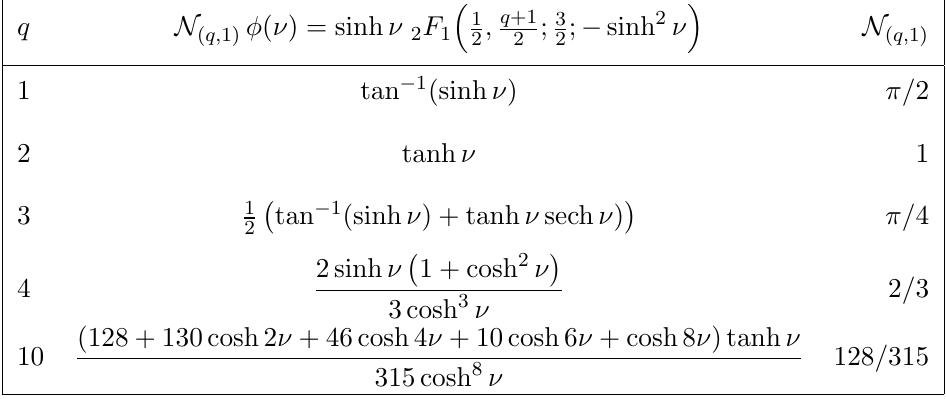
Table 1 . Exact double BPS kink solutions ( l = 1) for small values of q . Remember that a p -defect has q = p +